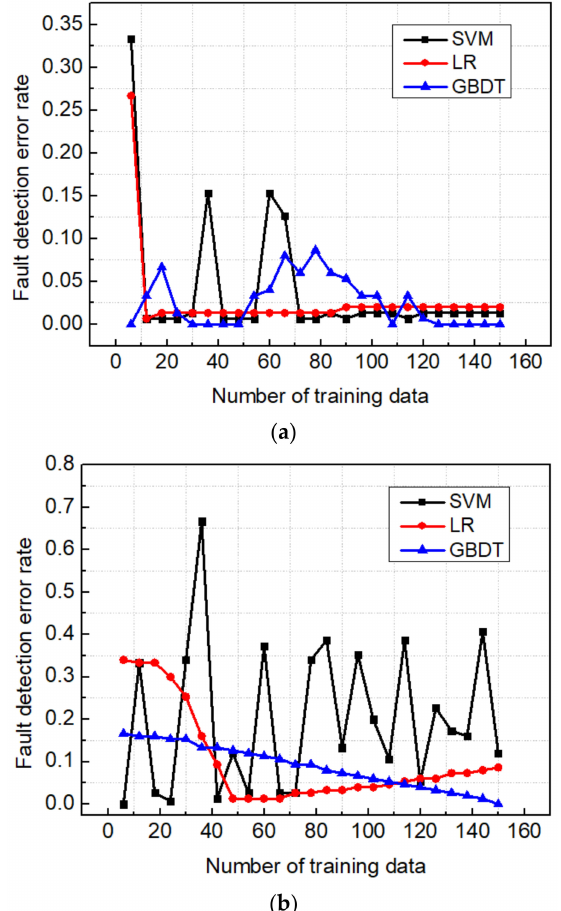
Figure 17. Fault detection error rate vs. number of training samples for different algorithms trained on ( a ) S 11 , ( b ) S 21